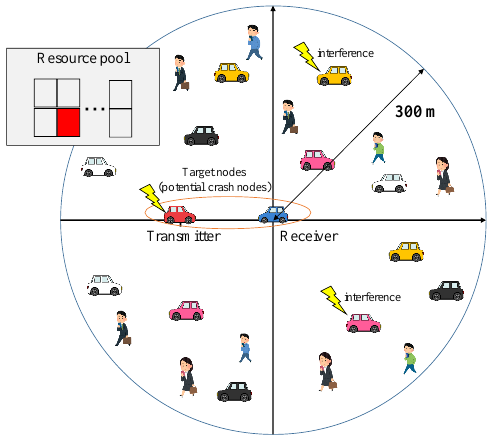
Figure 7. The abstract image of the simulation model of CWS: the transmitter and receiver are potential crash nodes.